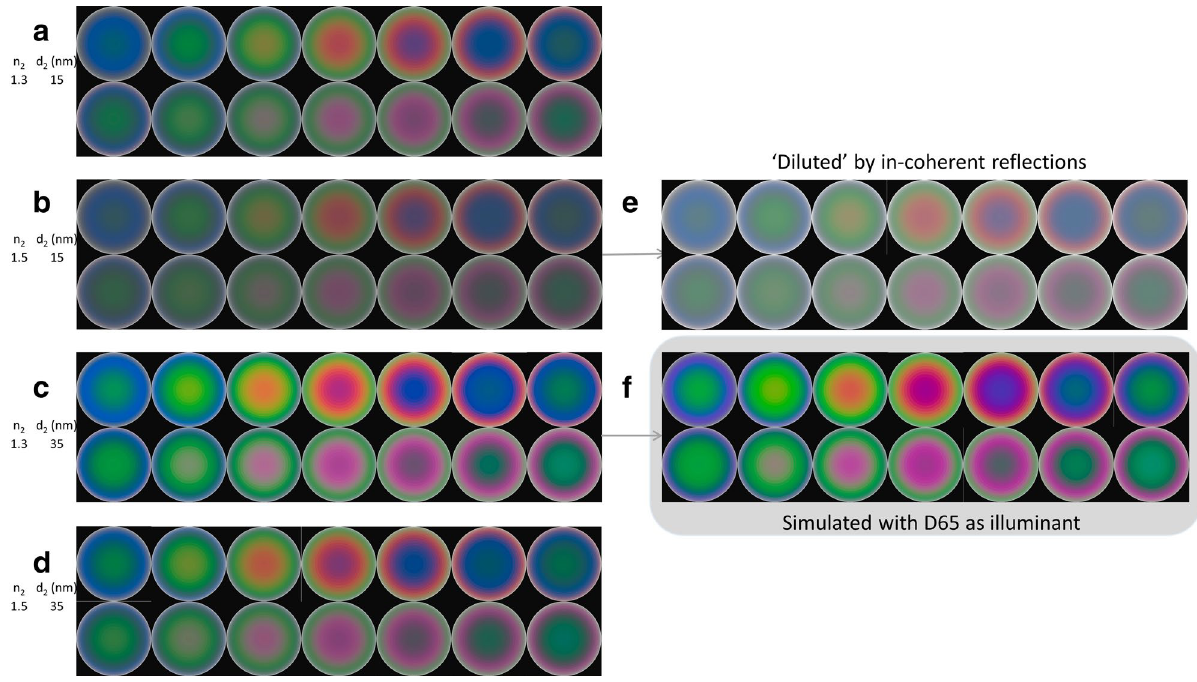
Figure 6. Interference pattern simulations with ( a )–( d ) showing the possible hue patterns; ( c ) the high saturation associated with thicker conchiolin layer; ( e ) the low saturation associated with lower conchiolin index; and ( f ) similar patterns with D65 as